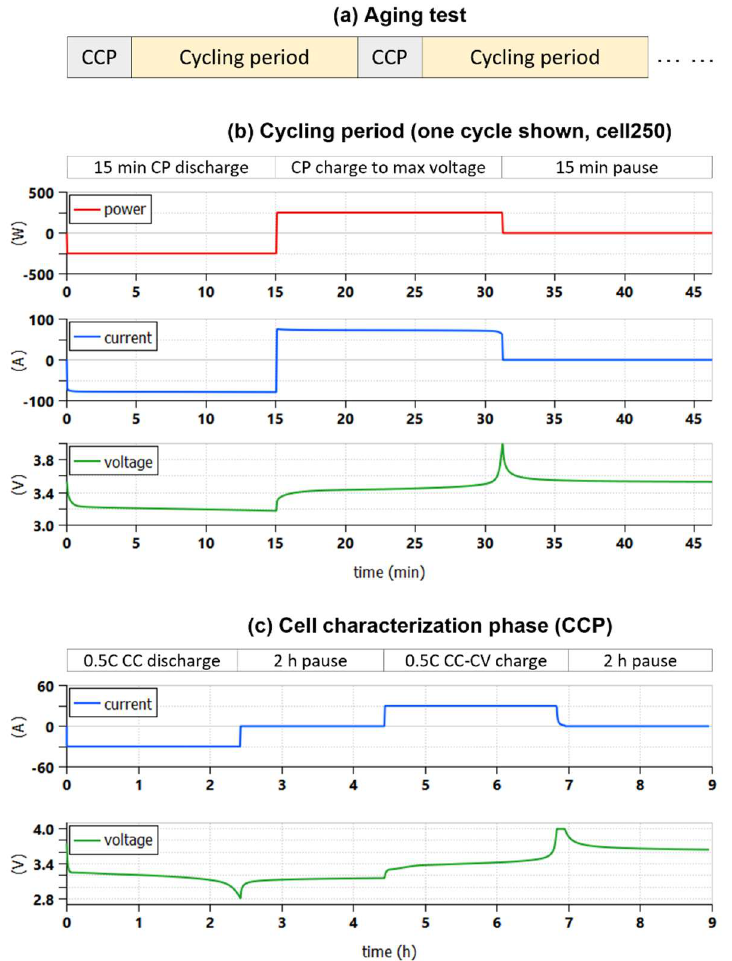
Figure 1. ( a ) Aging test structure: cycling periods interspersed with cell characterization phases (CCP). ( b ) Cycling period patterns: one single cycle shown, cell250 power, voltage, and current. ( c ) Cell characterization phase current and voltage.